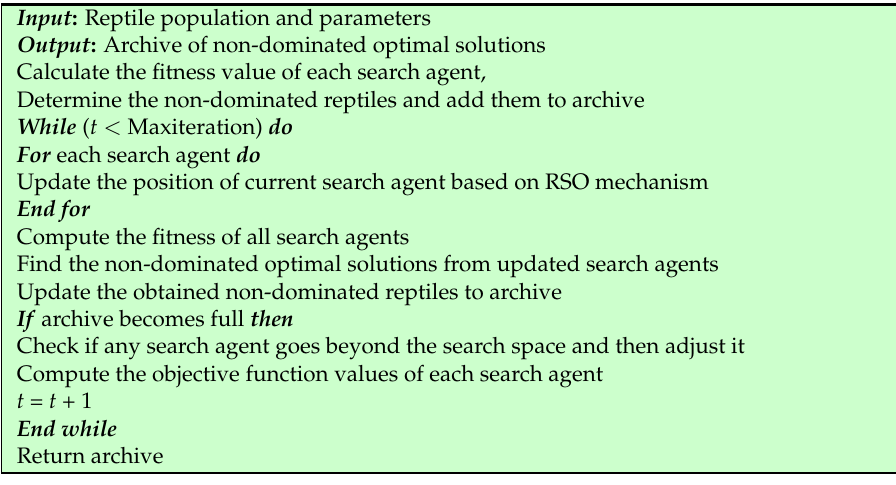
Figure 12. Flowchart of MORSO algorithm. Table 3. Pseudo-code of MORSO